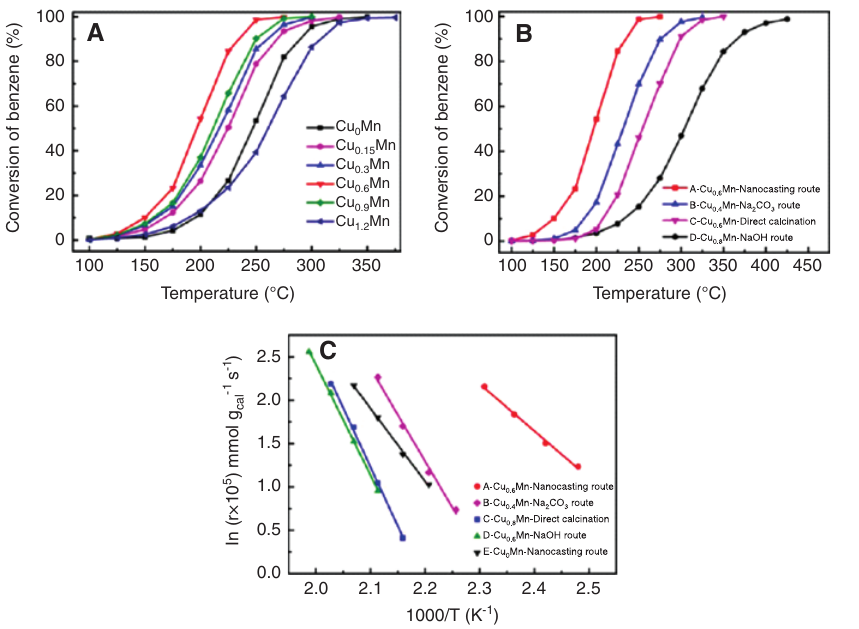
Figure 29: (A, B) Benzene conversion as a function of reaction temperature over Cu-Mn composite oxides prepared by nanocasting strategy and other methods, (C) Arrhenius plots for the oxidation of benzene over the Cu-Mn composite oxides synthesized by different methods. Reproduced from [120] with permission from Elsevier